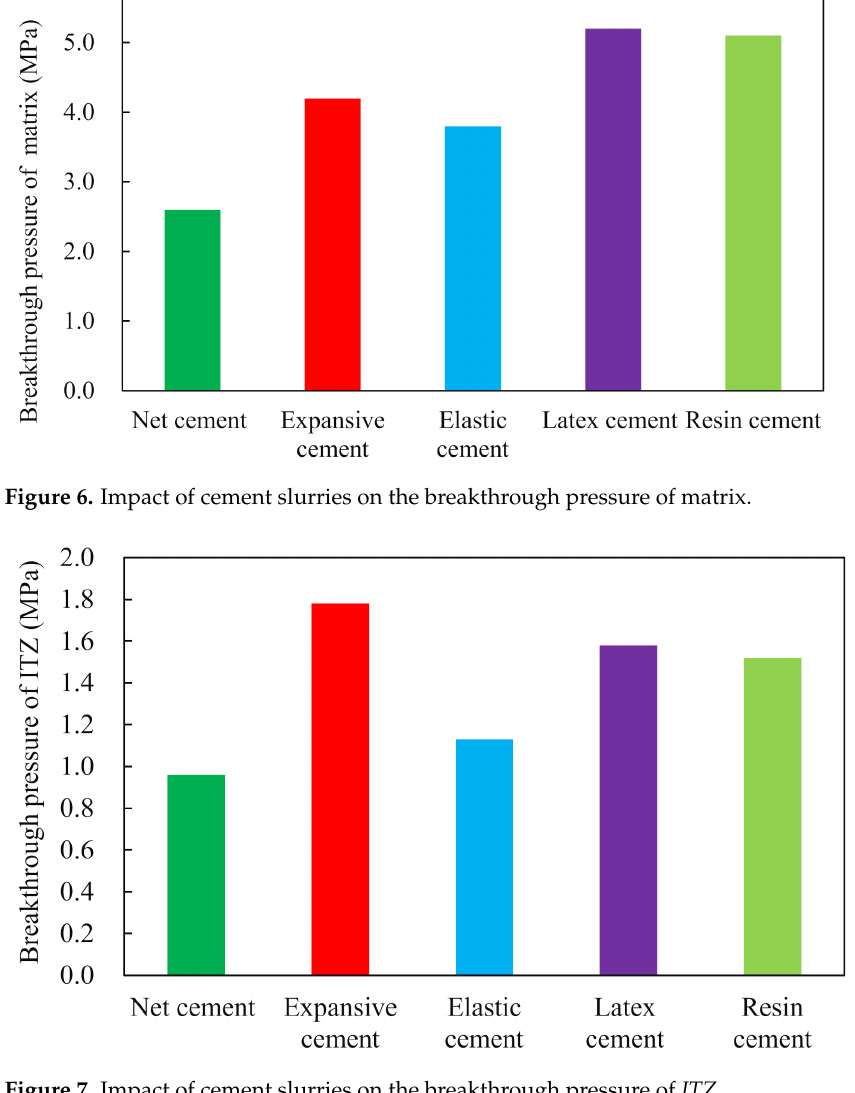
Figure 7. Impact of cement slurries on the breakthrough pressure of ITZ